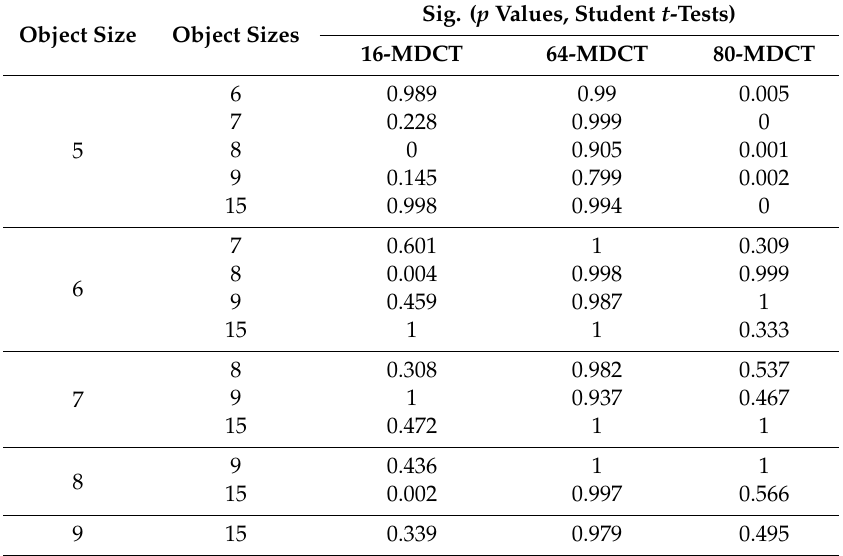
Table 5. Di ff erences in CNR values ( p values, student t -tests) between di ff erent object sizes at 1% contrast in each CT